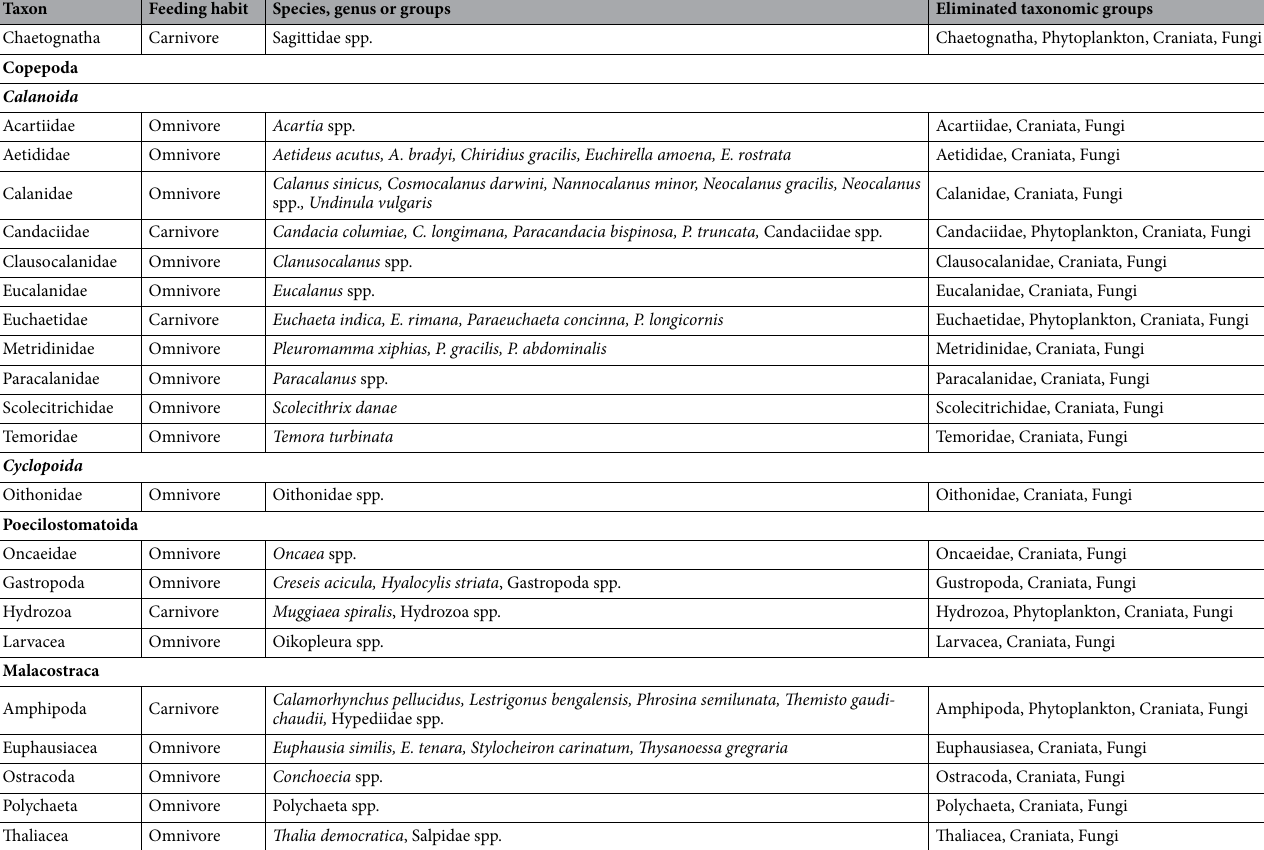
Table 1. Mesozooplankton taxonomic groups identified in gut contents in the present study. Taxonomic groups eliminated as host or contaminated organisms are also